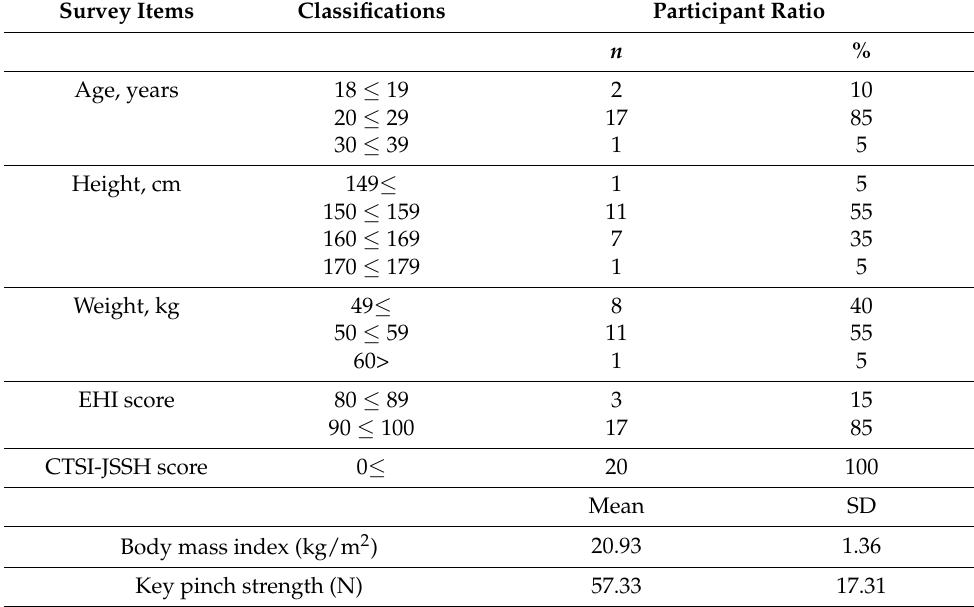
Table 1. Participant